Question: Summarize what this figure shows in one sentence.
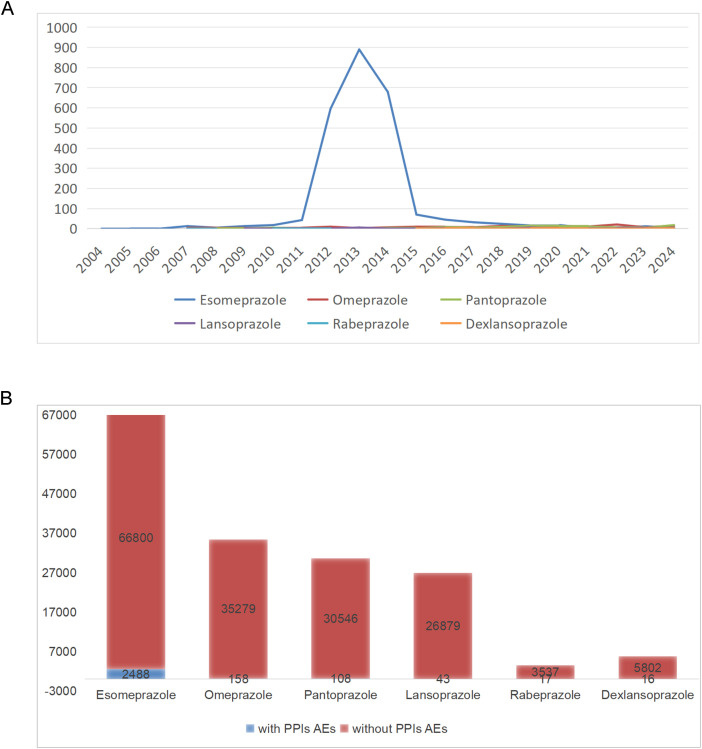
Answer: Time trends and case distribution of esomeprazole-associated OP reports in FAERS. (A) Quarterly reporting rate of OP events associated with esomeprazole from Q1 2004 to Q4 2024 in the FAERS database. (B) Comparison of the number of reports involving esomeprazole with versus without co-reported OP.